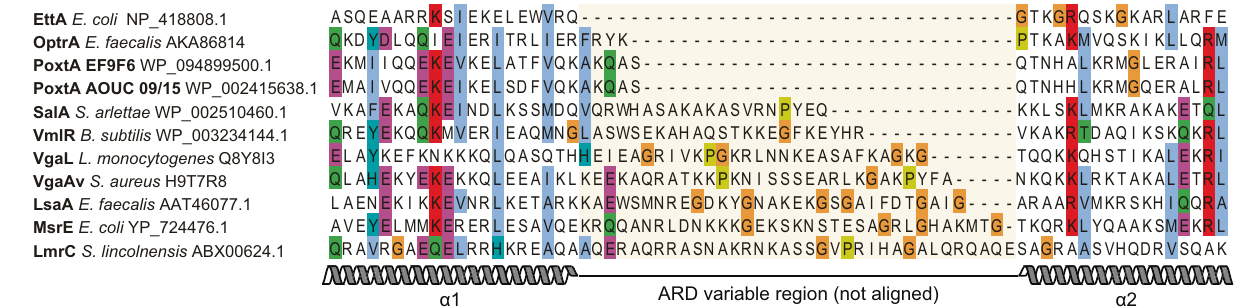
Fig. 1 Alignment of the ARDs from diverse bacterial ABCFs. The PoxtA and OptrA ARDs are slightly longer (4 – 5 amino acids) than the equivalent region in EttA, but signi fi cantly shorter than in other ARE – ABCFs. The central region with an orange highlight, which includes the ARD loop and some of the adjacent helices in some proteins, was not aligned but simply ordered by length. Sequences were aligned with MAFFT 70 and edited by hand to reduce gap placement. Sequence accession numbers in the title are Uniprot or NCBI protein accessions.